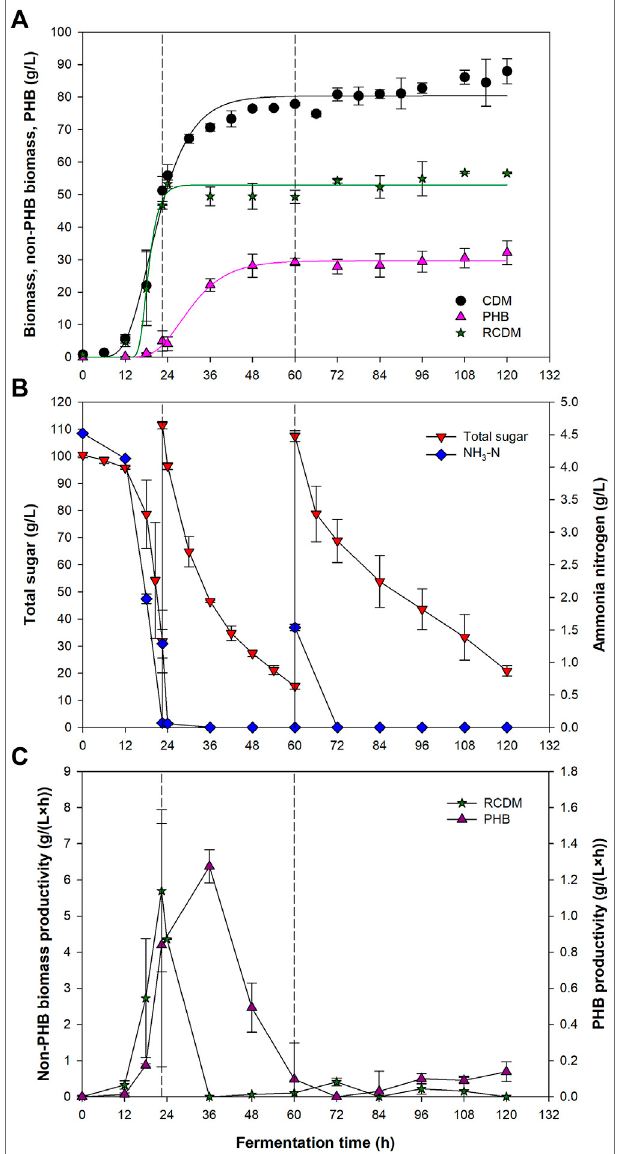
FIGURE 4 | Cell dry mass (CDM), PHB, residual CDM (A) , total sugar and ammonia nitrogen concentrations (B) , and total sugar consumption rate andPHBproductionrate (C) duringfed-batchfermentationof Paracoccus sp. KKU01 in SJ-based medium. The solid lines in (A) represent data predicted by the modi fi ed Gompertz model ( Eq. 2 ). The dashed lines represent the time at which fresh medium was fed into the bioreactor.